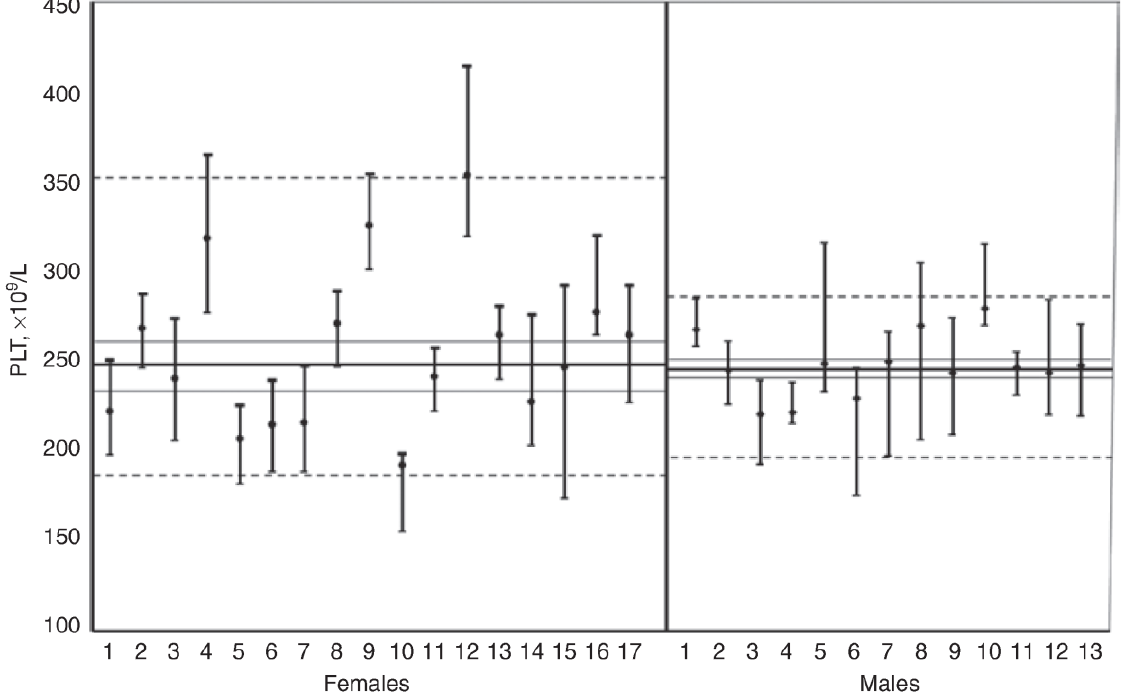
Figure 5. Median values with range (minimum–maximum) of platelet count for individuals based on weekly samplings for 10 weeks. Dashed lines indicate the 5th and 95th percentiles, and the continuous line is the median value with 95% CIs. Reprinted from Ref. [152]. The within-person variation and the set point of each individual are different and additionally, the variation of the set point for males is lower than that for